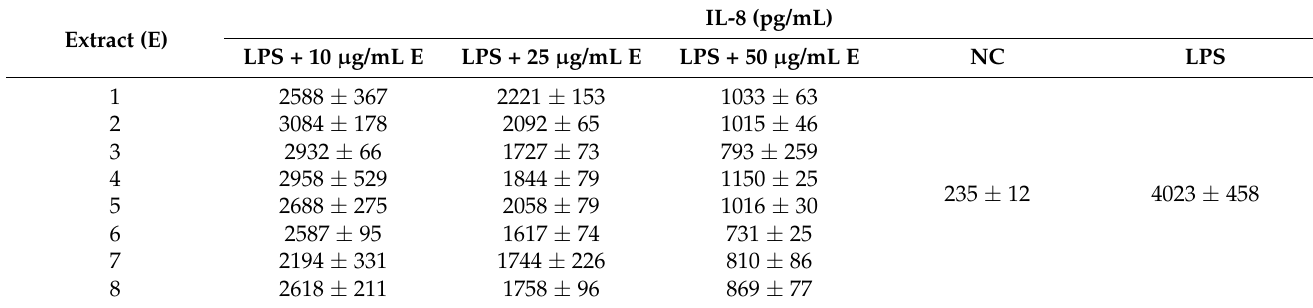
Table 11. The anti-inflammatory potential of Epilobium sp. extracts. The quantity of IL-8 was measured from cellular supernatants after a 24 h exposure to the extracts (10, 25, and 50 µ g/mL) in combination with 100 ng/mL LPS. Data are expressed as mean ± standard deviation of three biological replicates.